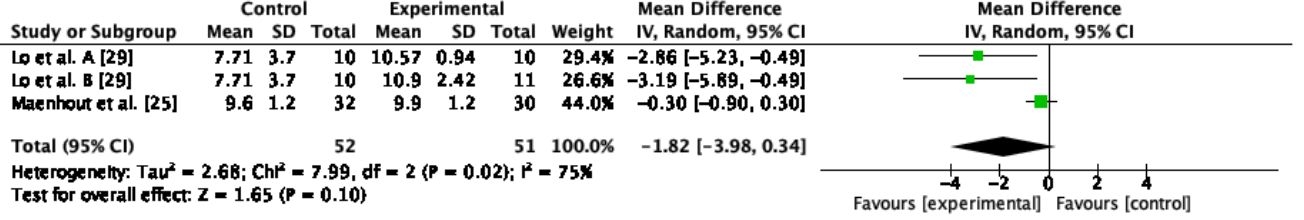
Figure 10. Forest plot of subacromial space for conservative therapy versus control/sham and conservative therapy versus other conservative therapy. Lo et al. A compared KT versus control intervention. Lo et al. B compared stretching versus control intervention.